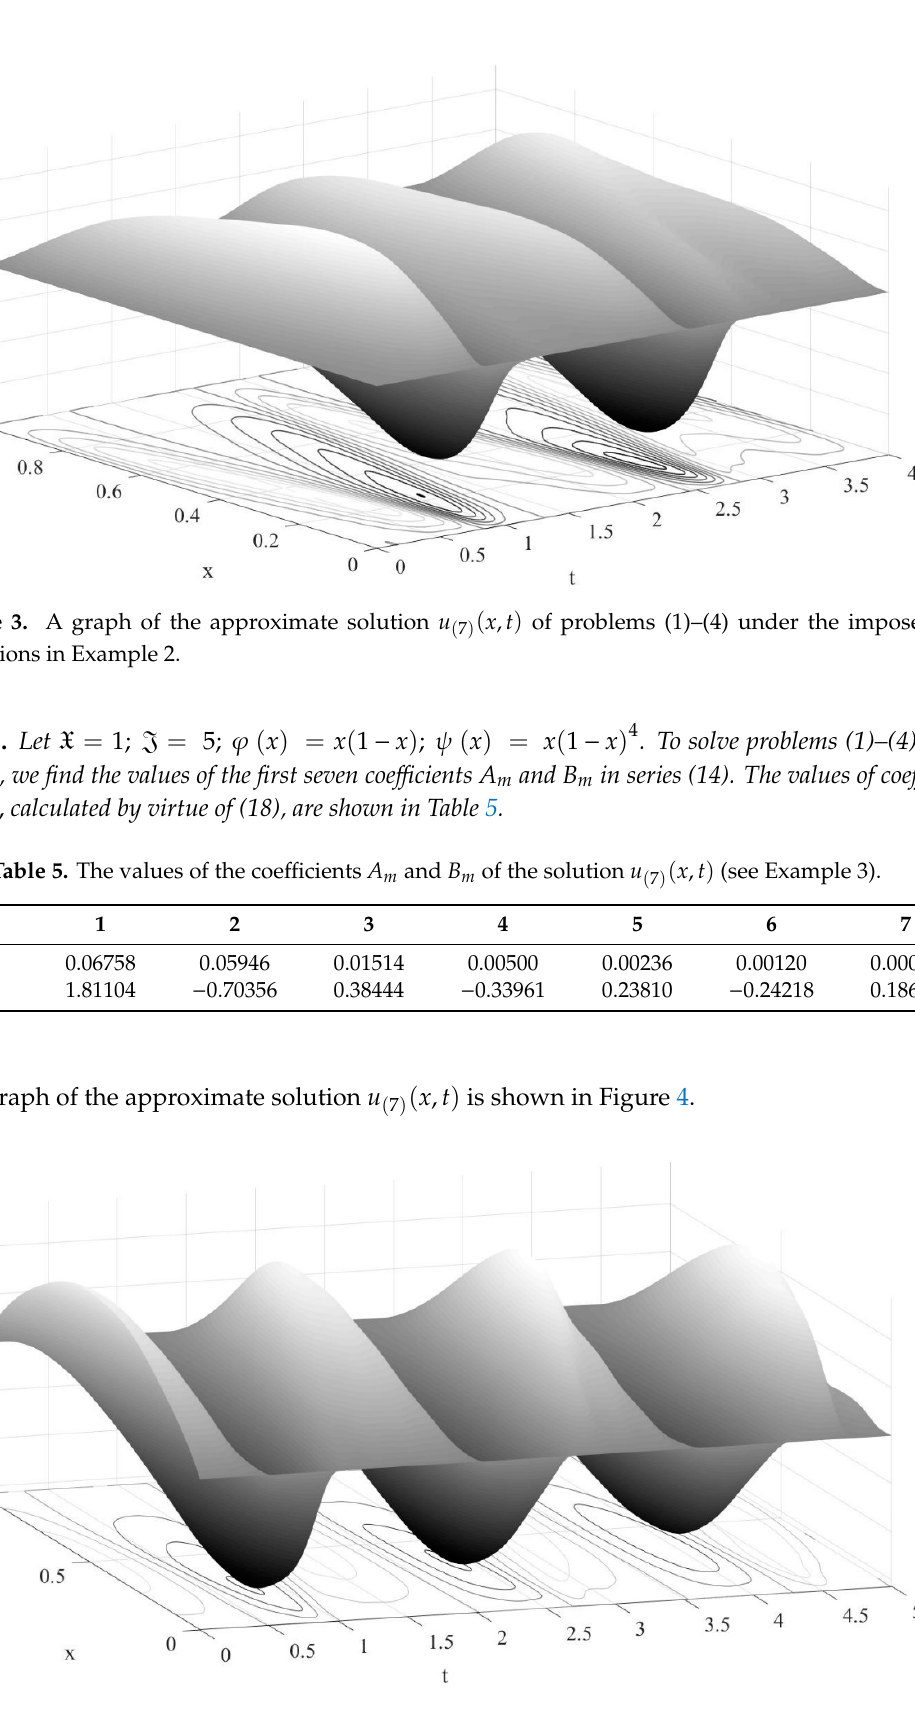
Table 4. The values of coefficients 𝐴 (cid:3040) and 𝐵 (cid:3040) of the solution 𝑢 ((cid:2875)) (𝑥,𝑡) (see Example 2). 𝒎